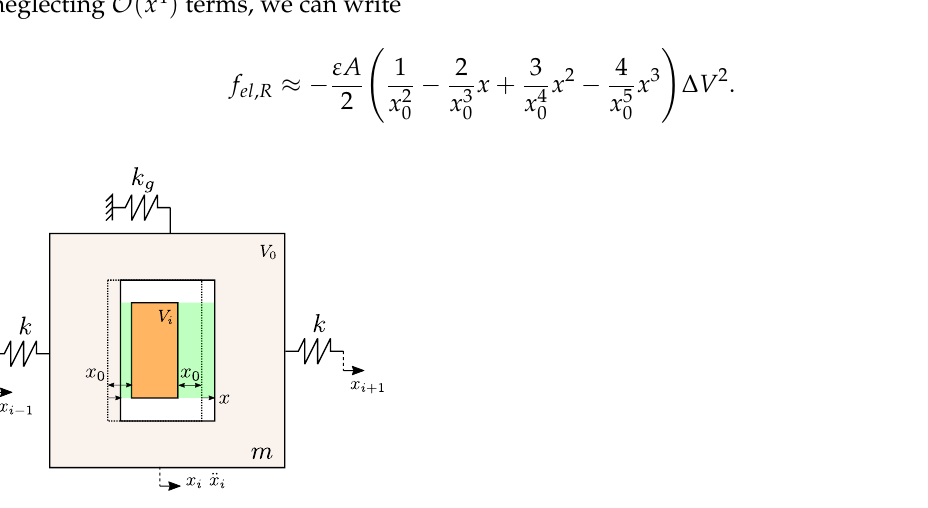
Figure 2. Sub-cell scheme considering a mass displaced by x . The area of interest for electrostatic forces is highlighted in light